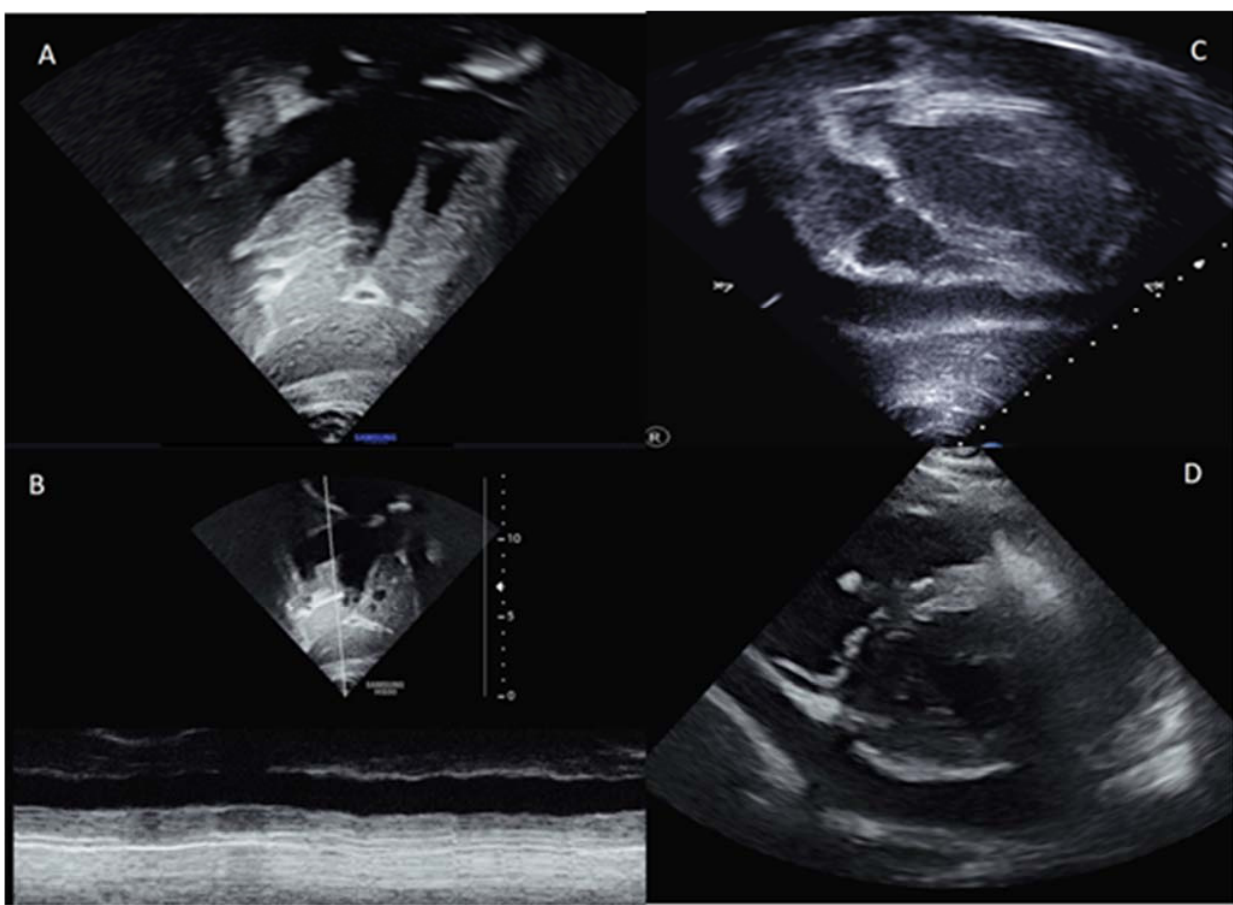
Figure 1. The 12 ‐ leads ECG performed at admission.